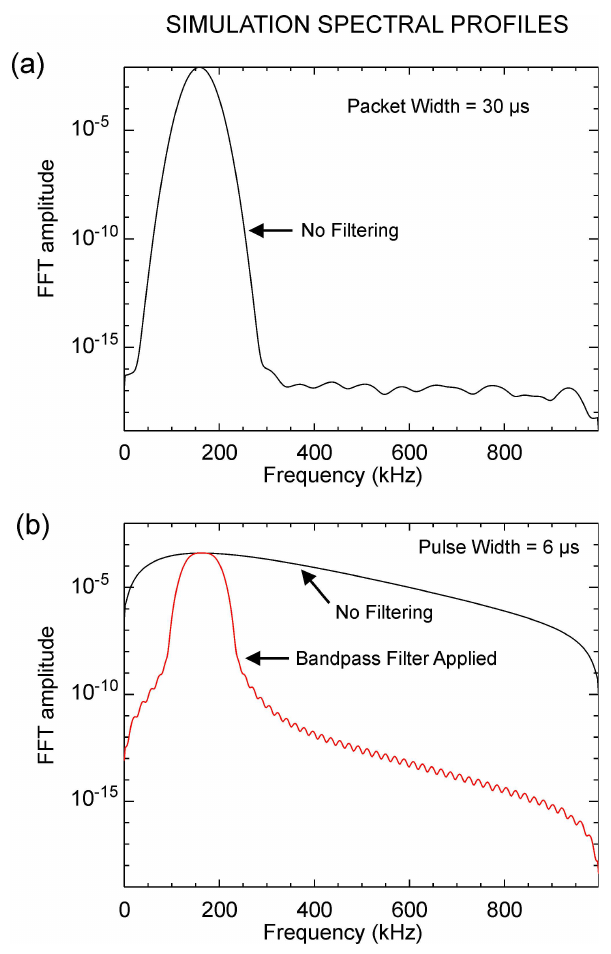
Fig. 4. Spectral profiles (amplitude vs. frequency) of simulated waveform data from Fig. 3 before down conversion. (a) Spectrum of the waveform packet presented in Fig. 3a showing a spectral peak at about 160kHz, the energy being almost fully contained within the 125–202kHz frequency band. (b) Black line: spectrum of the pulse presented in Fig. 3c showing a broad band nearly covering the en- tire Fourier frequency space, with much of the energy outside the 125–202kHz frequency band. Red line: spectrum of the pulse after filtering down to the 125–202kHz frequency band to show compar- ison with the profile in Fig.